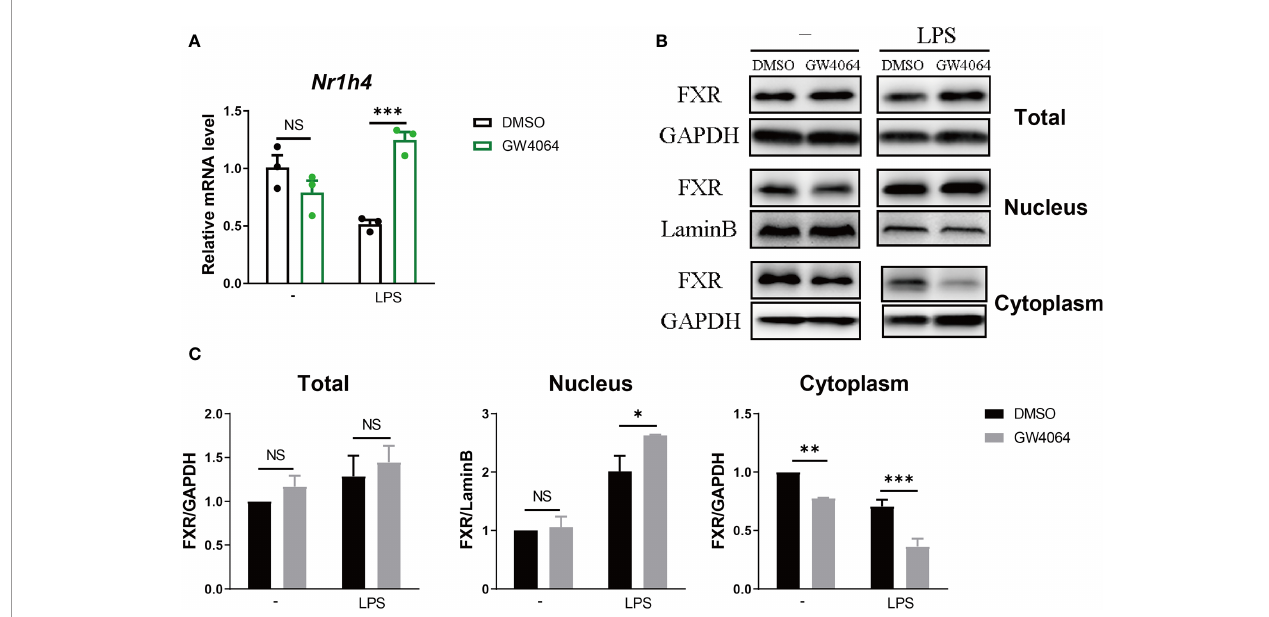
FIGURE 5 | FXR Agonist Facilitates the Translocation of FXR into the Nucleus. (A, B) RAW 264.7 macrophages were incubated with or without 5 m M FXR agonist GW4064 for 24h, and then stimulated with or without 100ng/ml LPS. The mRNA levels of FXR within the cells (A) were tested 6h after the stimulation and total protein levels as well as nuclear and cytoplasmic protein levels were tested 24h (B) after the stimulation. (C) Quanti fi cation of the western results from (B) . Data are shown as mean ± SEM. *p < 0.05; **p < 0.01; ***p < 0.001; NS, no signi fi cant difference, two-way ANOVA, followed by Sidak ’ s multiple comparisons